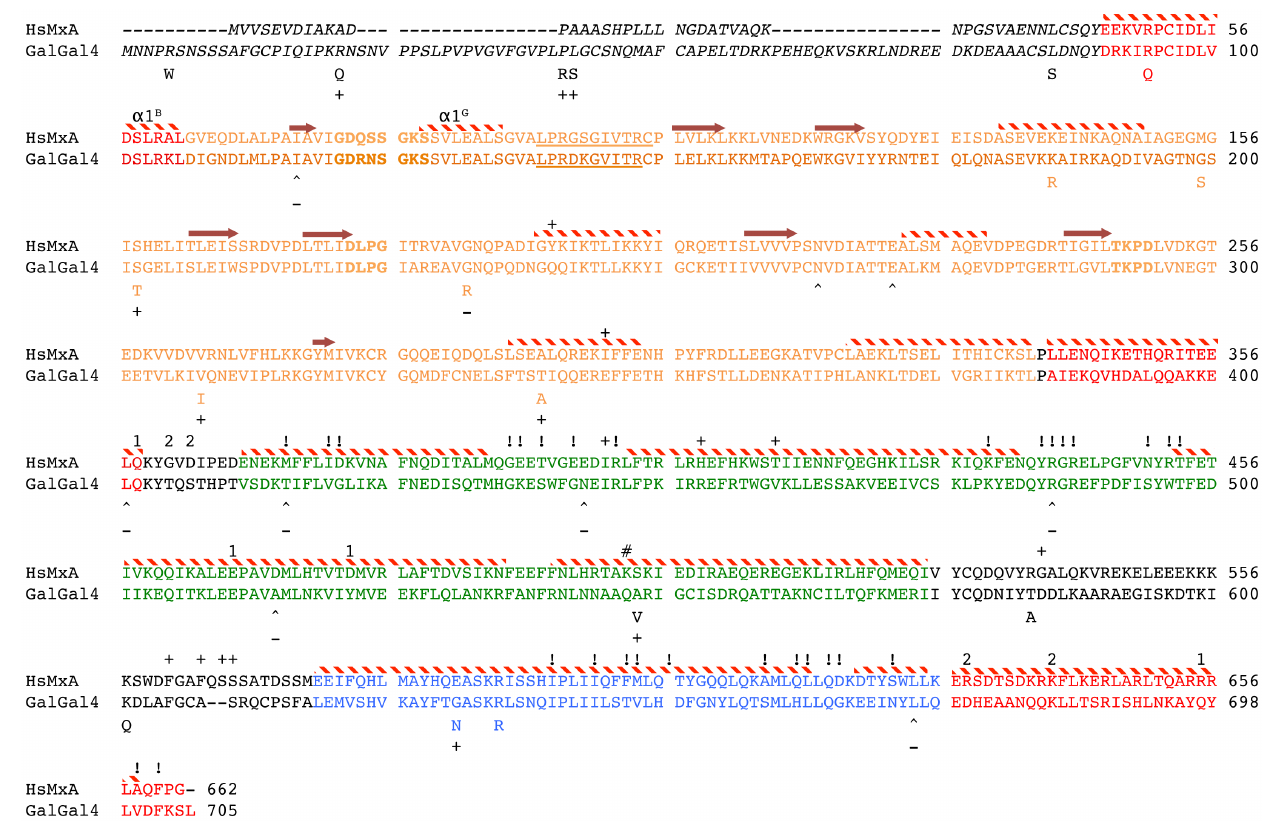
Figure 3. Amino acid alignment of the HsMxA and galGal4. The different Mx functional domains are represented in colored text (BSE = red, G-domain = orange, Middle stalk domain = green, GTPase effector domain = blue) with the N-terminal region not represented in shown in italics, and the loop regions that connect BSE2 to MD (L1 BS ) and MD to GED (L4 S ) in plain text. Positions in orange bold represent the conserved GTPase enzymatic domain and underlined orange text denotes the GTP binding site. Secondary structural elements as described by Gao et al. [23] et al. are indicated above the HsMxA sequence. Alpha helices are represented by red and with stripped bars. Beta strands are represented by arrows. Amino acids with similar numbers above the alignment indicate positions described to interact during oligimerization. HsMxA positions labeled with ‘‘ # ’’ indicates amino acid with forms hydrogen bonds with the backbone of the a 3 B , and ‘‘!’’ denote additional positions described to be involved in oligemerization. ‘‘ + ’’ above the hsMxA indicates amino acid described by Mitchell et al. [30] as under diversifying selection among primate MxA sequences. Amino acid positions in the chMx associated with dNS changes are reflected by the alternate amino acid under the chMx sequence. Positions associated with dS nt changes are indicated by ‘‘ ‘ ’’. chMx positions with evidence of diversifying (dNS) or purifying (dS) selection are indicated with ‘‘ + ’’ or ‘‘ 2 ’’ under the chMx sequence.